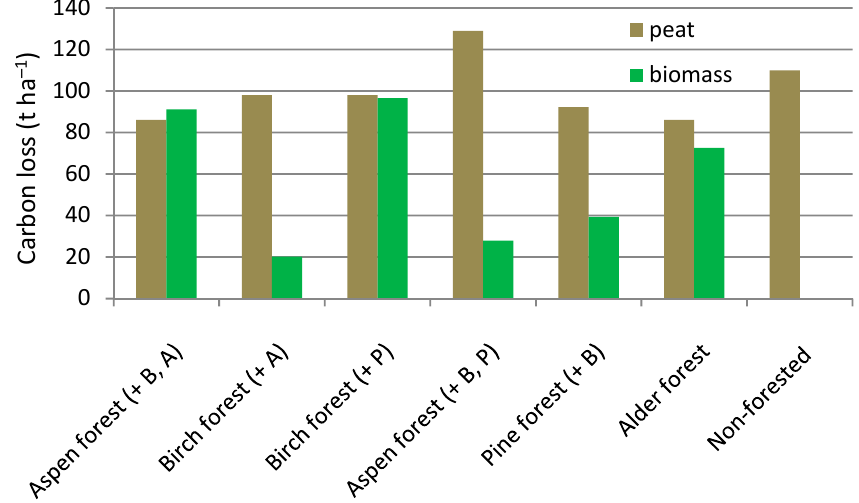
Figure 7. Biomass and peat carbon losses in sites with different woody vegetation. A, Alder; B, Birch; P, Pine.